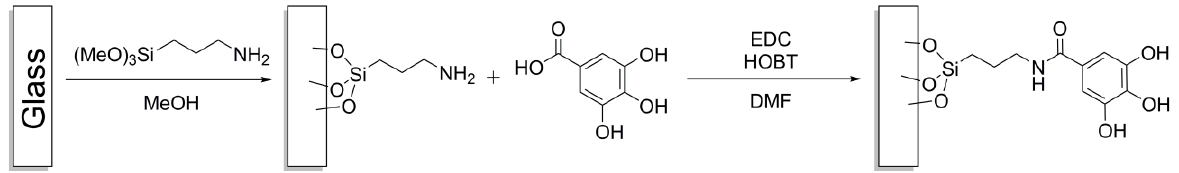
Figure 3. Two-step surface functionalization of (1) silanization followed by (2) amidation coupling.